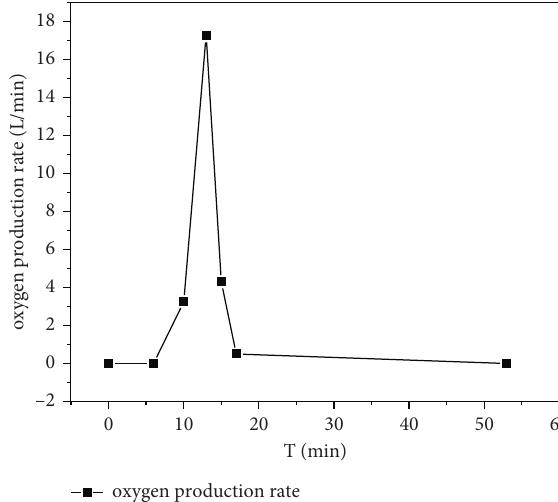
Figure 8: Oxygen candle O 2 production rate curve of test space.